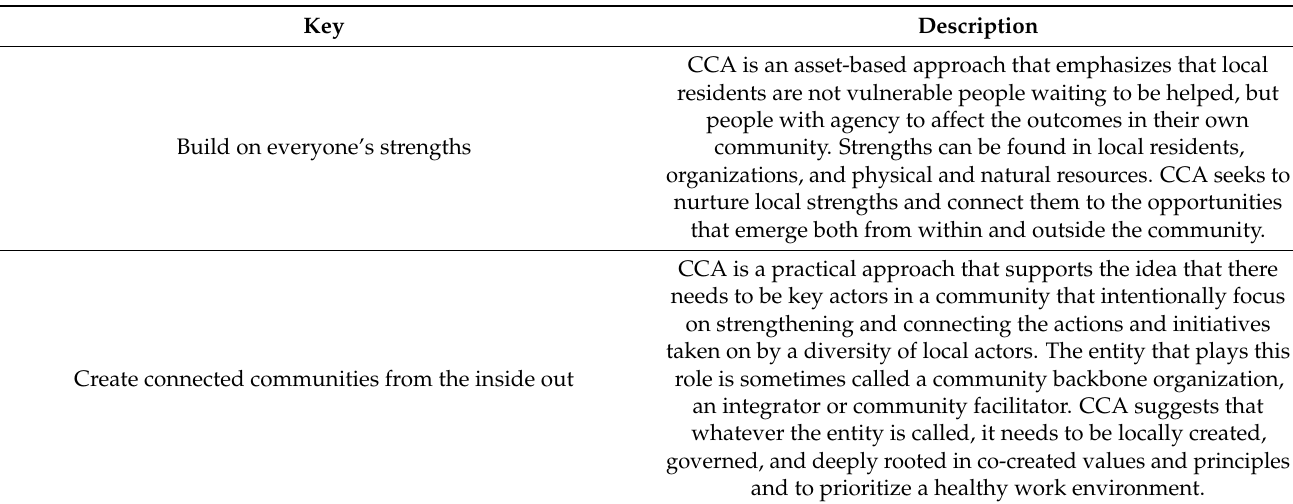
Table 2. Ten keys for a Connected Communities Approach